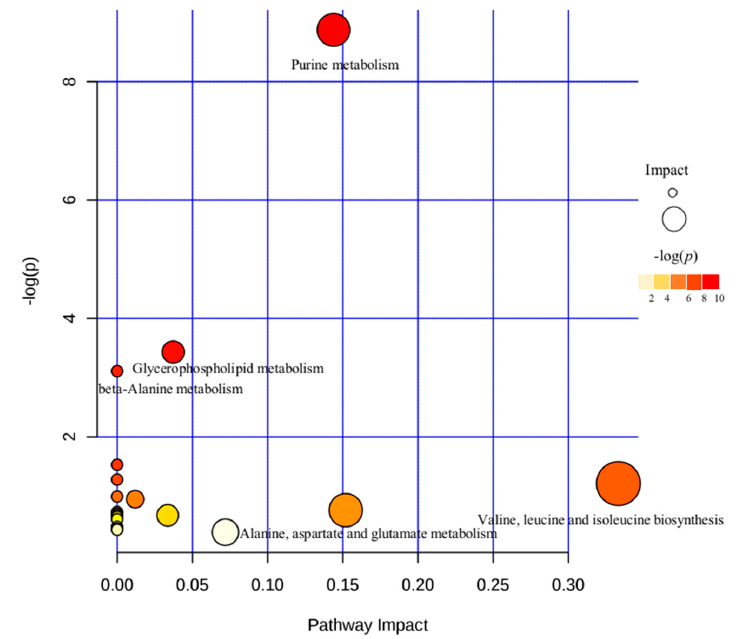
Figure 5. Heat maps of 30 di ff erently identified metabolites from the mandible muscles of the three di ff erent treatment group ants: healthy ants (CO, colored green); B. bassiana -infected ants (BE, colored red); and O. unilateralis -infected ants (OR, colored blue). Each metabolite was represented by a single row of colored boxes, where columns represented di ff erent samples. Metabolite levels are scaled by colors. The red labels show high intensities levels and light blue labels mean low intensities of metabolites levels using Euclidean distance measure.